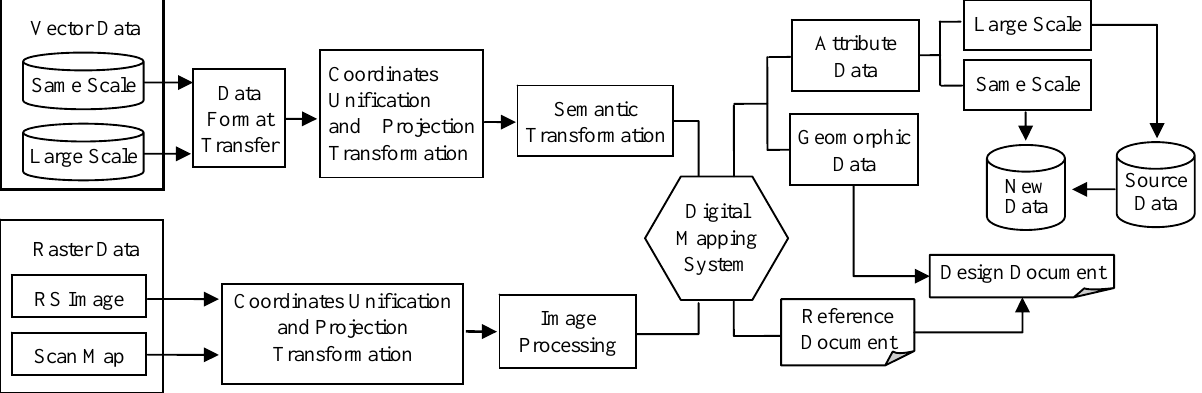
Figure 3. Technical workflow chart of multi-source data integration The chart of multi-source data integration for some region is shown in Figure 4. The yellow one is the vector data of large scale, and the colorized one is the vector data of the same scale. While the raster data at the bottom is the